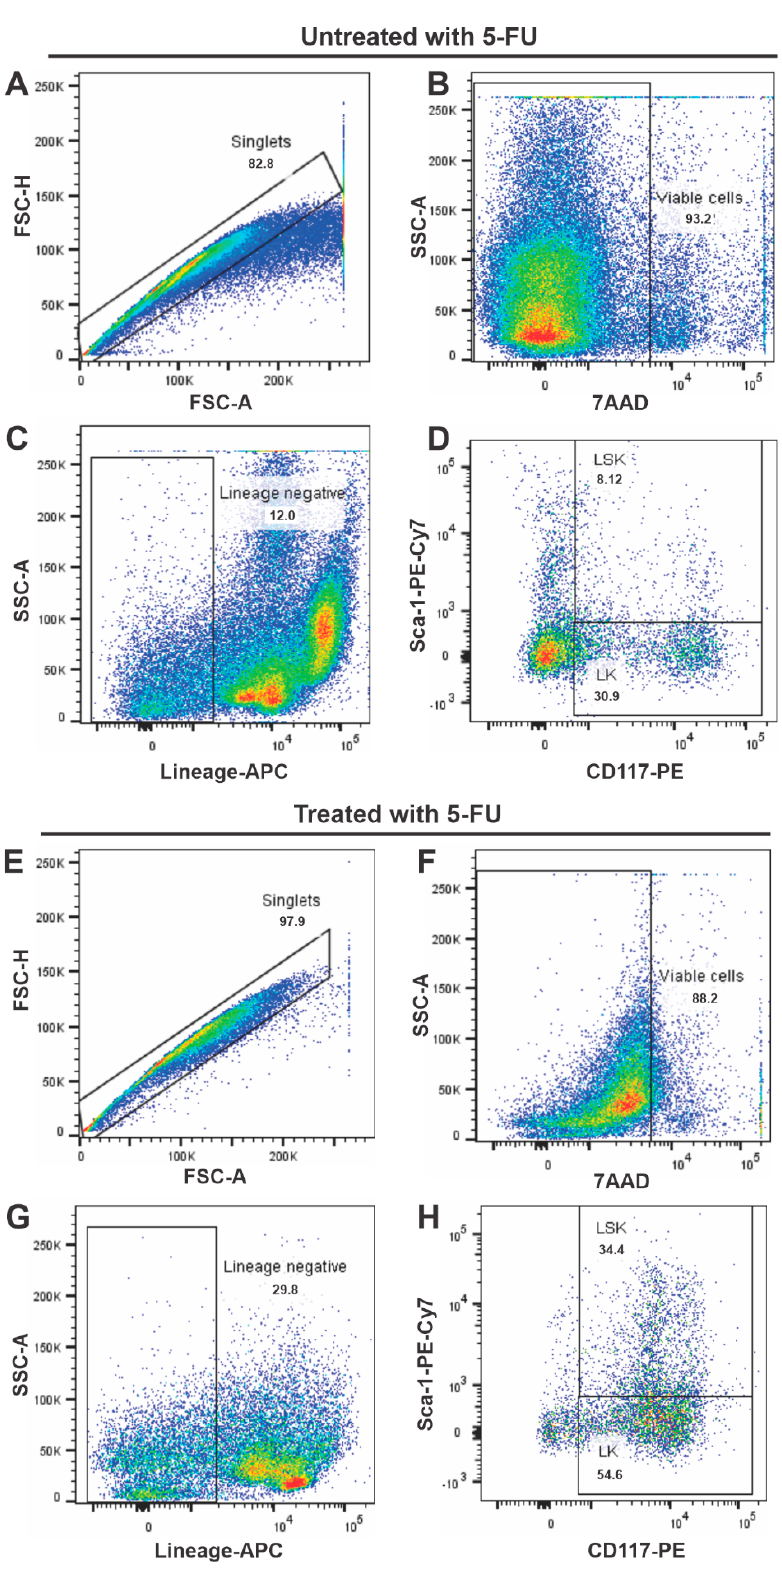
Figure 1. Comparative flow cytometry analysis. Analysis for singlets cells and exclusion of doublets ( A , E ). Analysis for viable cells ( B , F ). Evaluation of APC antibodies cocktail for hematopoietic cell lines (CD3+, CD45R+, Ly6C+, Ly6G+, CD11b+, and TER-119+) ( C , G ). LSK (Lineage − , c-kit + , and sca-1 + ), LK (Lineage − , sca-1 − , c-kit + ) of control animals ( C , D ) and 5-FU treated animals ( G , H